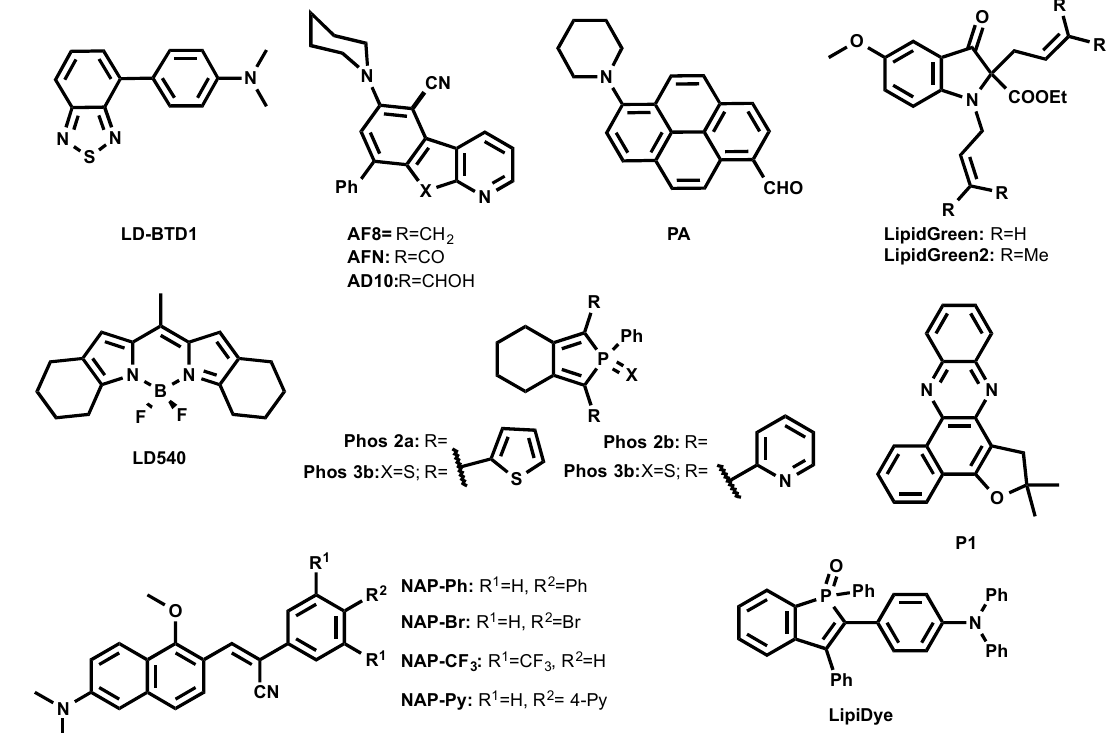
Figure 4. Chemical structures of green-emitting LD probes.